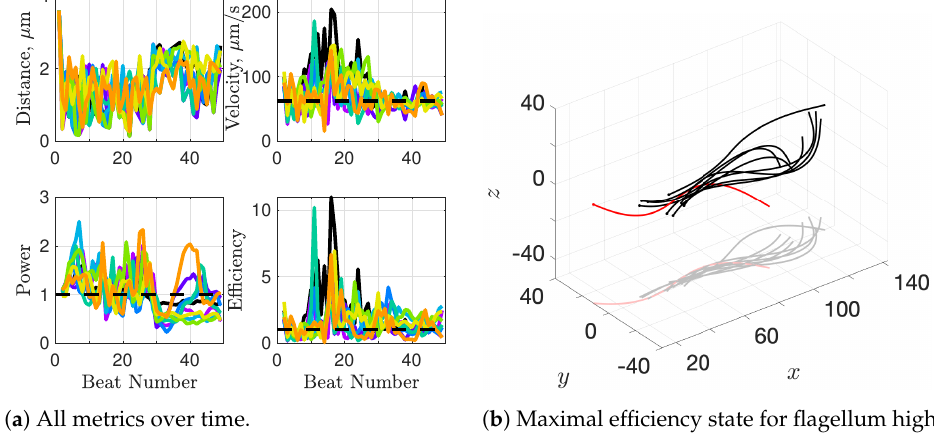
Figure 18. Comparison of minimal distances to other flagella, velocity, power and efficiency of apical hook model. In panel ( a ), we see all metrics plotted over time. Color of curves indicates data for flagellum of matching color from the initial configuration, shown in Figure 4a. In panel ( b ), we show the configuration for maximal efficiency of the leading